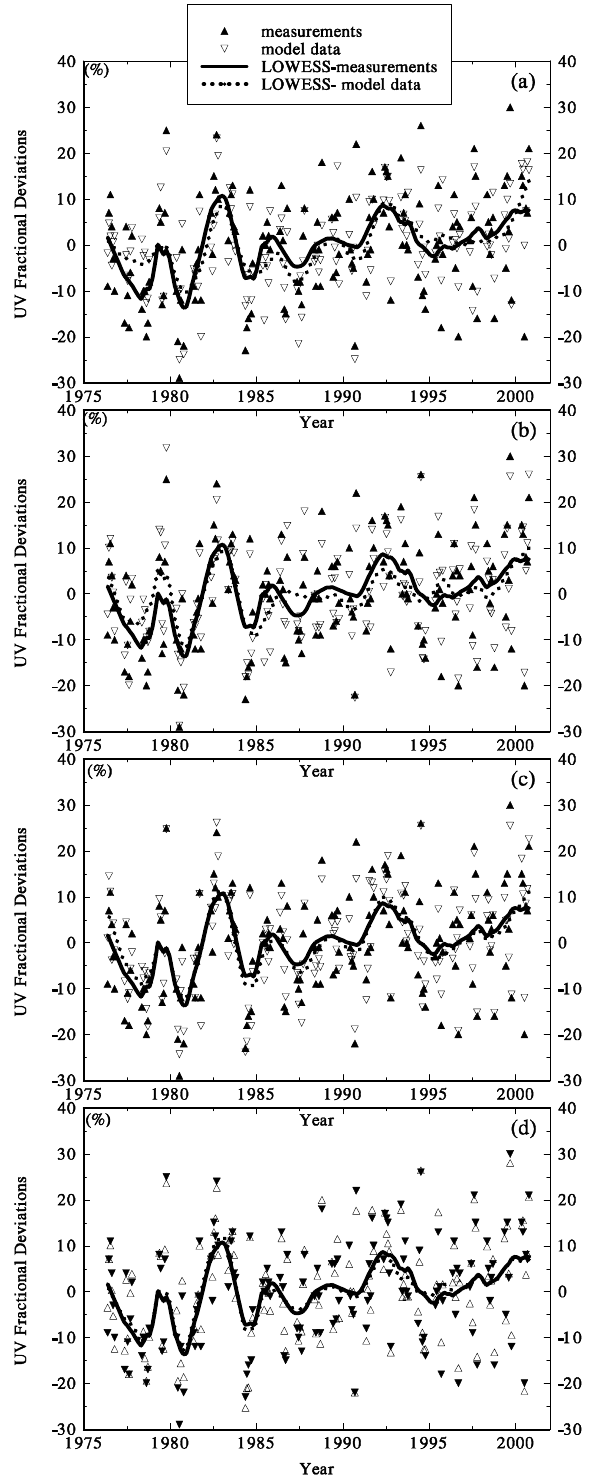
Fig. 3. Time series of the observed and modeled year-to-year fluc- tuations in the UV fractional deviations for the snowless part (May through October) of the year in the period 1976–2000. The solid and dotted curve represent the smoothed pattern of the observed (full triangles) and modeled (empty triangles) fractional deviations, respectively. Figures 3a–d correspond to results by model A, B, C, and D, defined in Sect.